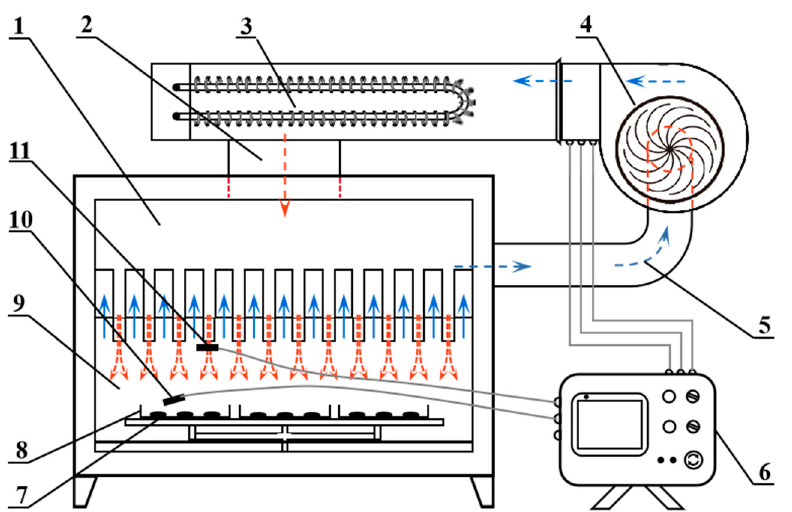
Figure 1. Schematic diagram of the hot air impingement dryer. 1. Airflow distribution chamber; 2. drying air channel; 3. electric heater; 4. centrifugal fan; 5. drying air recycle channel; 6. temperature sensor of the controller; 7. sample; 8. sample tray; 9. drying chamber with series of round nozzles; 10. temperature sensor; and 11. air velocity